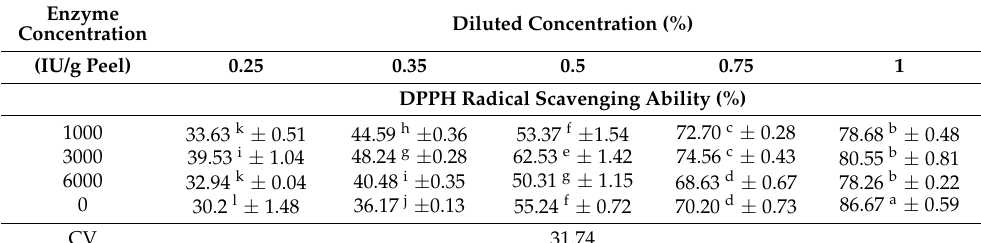
Table 5. DPPH free radical scavenging activity of pomegranate